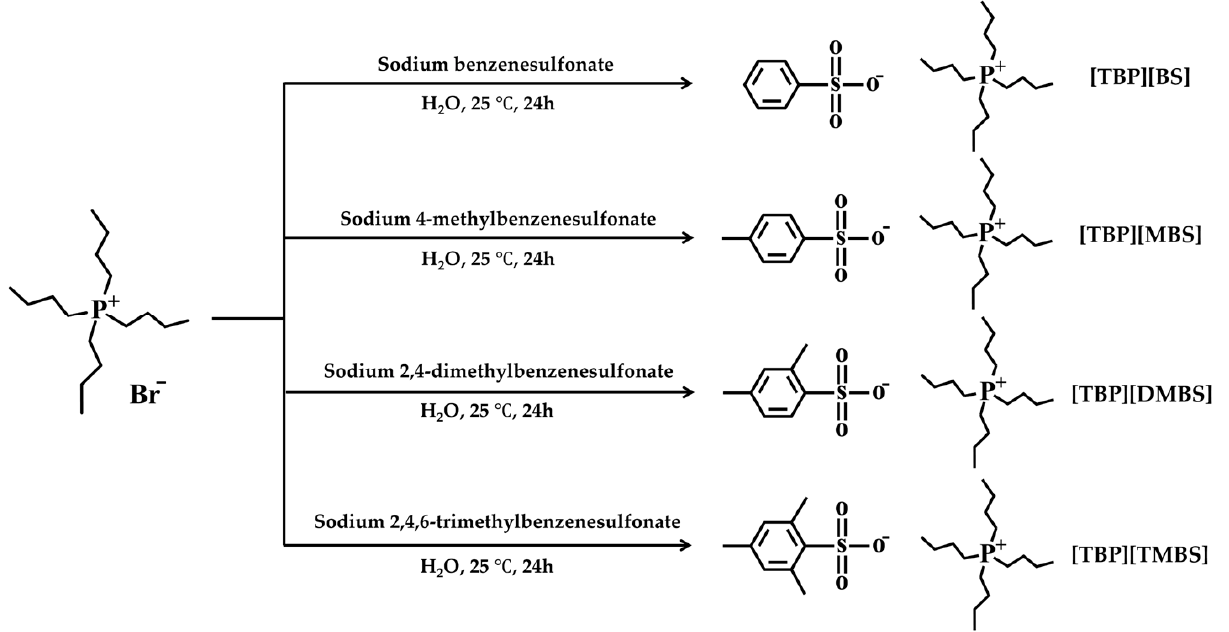
Figure 1. Synthetic route of [TBP][BS], [TBP][MBS], [TBP][DMBS], and [TBP][TMBS].